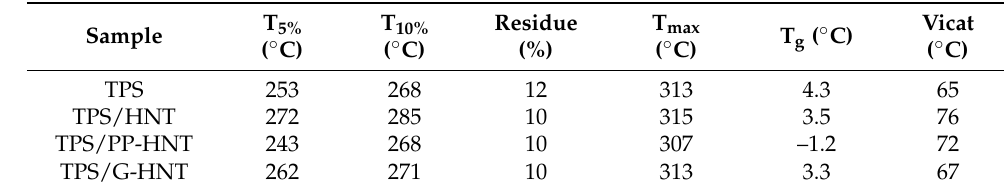
Figure 9. TGA ( a ) and DSC ( b ) thermograms of unmodified and modified TPS.